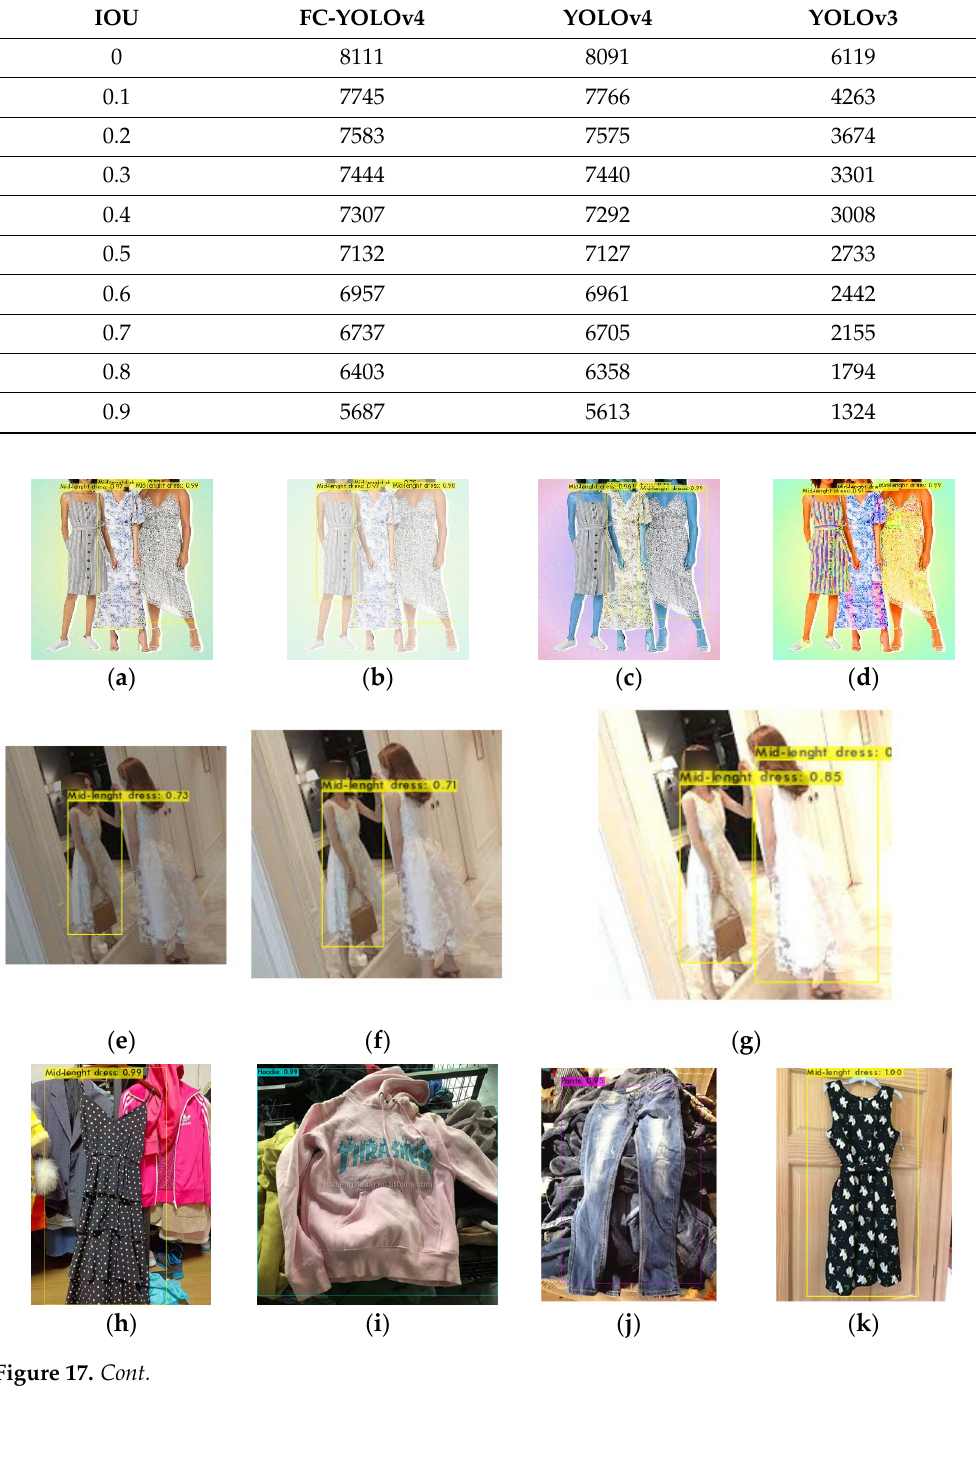
( q ) Figure 17. Detection results of our proposed FC-YOLOv4. ( a – d ) FC-YOLOv4 Overlaping Detec- tion; ( e – g ) High Brightness Overlaping Detection; ( h – k ) Cluttered Background Detection; ( l – n )Ro- tated Images Detection; ( o – q ) Multiple Categories Detection. In our research of how popular object detectors such as YOLOv4 can be modified to detect objects, we identified architectural modifications that yield a significant perfor- mance boost over the original model at a relatively cheap cost, as the new model retains speed. The scenario in which we applied the suggested approach, namely autonomous